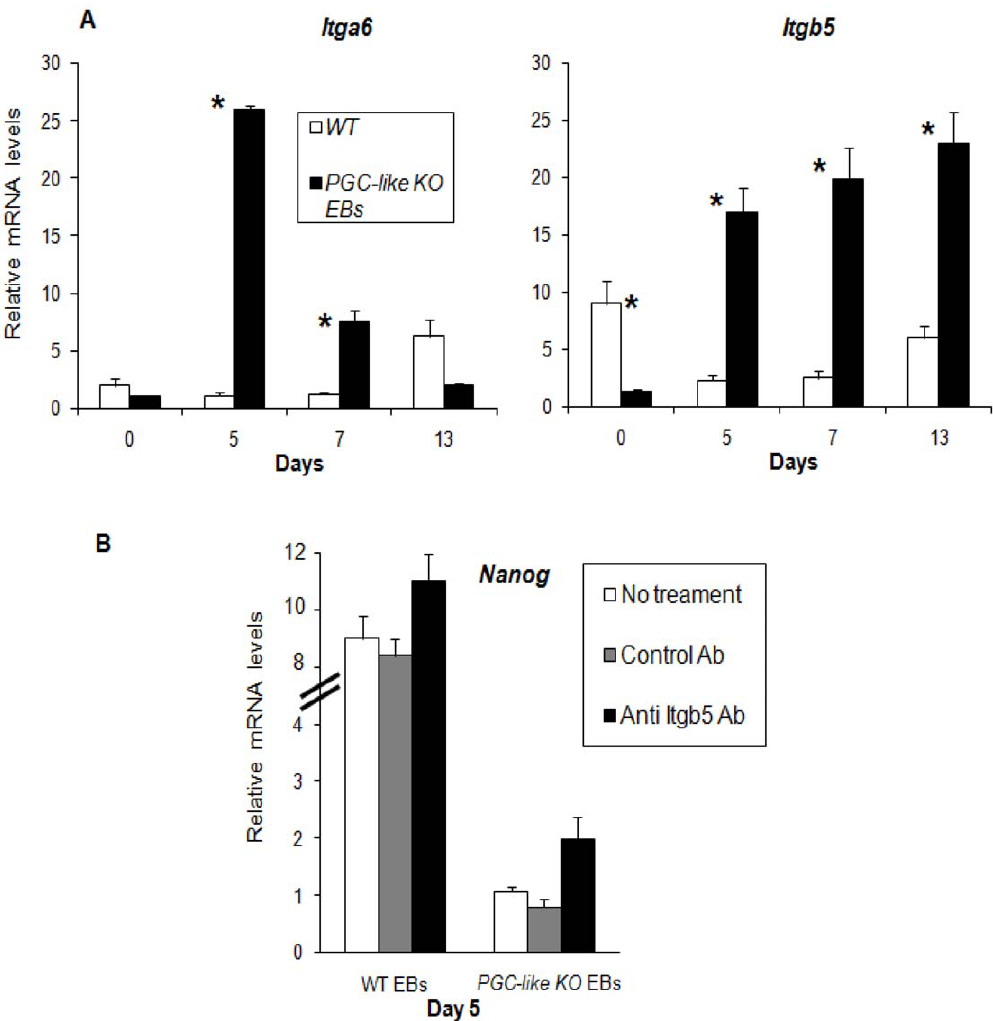
Figure 8. Influence of Prnp in the integrin matrix. A) Detection of PRNP-related integrins ( Itga6 and Itgb5 ) in WT and KO stem cells on Day 0, and in WT EBs and PGC-like KO EBs on Days 5, 7 and 13. B) Blocking of ITGB5 by a polyclonal antibody shows that Nanog mRNA transcription is ITGB5- dependent during differentiation (*indicates significant differences between WT and PGC-like KO EBs on a particular day (P , 0.05)) (Error bars, s.e.m.).